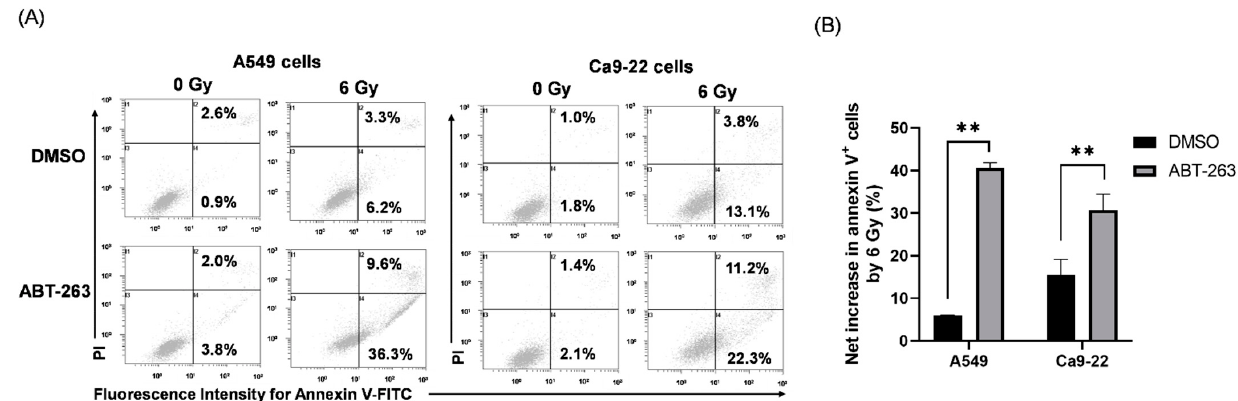
Figure 3. Effects of ABT-263 on the induction of apoptosis of irradiated cancer cells: ( A , B ) X-irradiated A549 and Ca9-22 cells were cultured for 24 h prior to the addition of ABT-263 to the culture (5 μ M for A549 cells and 10 μ M for Ca9-22 cells). After 24 h of culture, the cells including floating cells were harvested for apoptosis analysis. ( A ) Representative cytograms are shown. The inset numbers indicate the percentage of annexin V + /propidium iodine (PI) − cells or annexin V + /PI + cells. ( B ) The net increase in annexin V + apoptotic cells (sum of annexin V + /PI − cells and annexin V + /PI + cells) by 6 Gy is shown. Data are presented as the mean ± SD of independent experiments. ** p < 0.01.